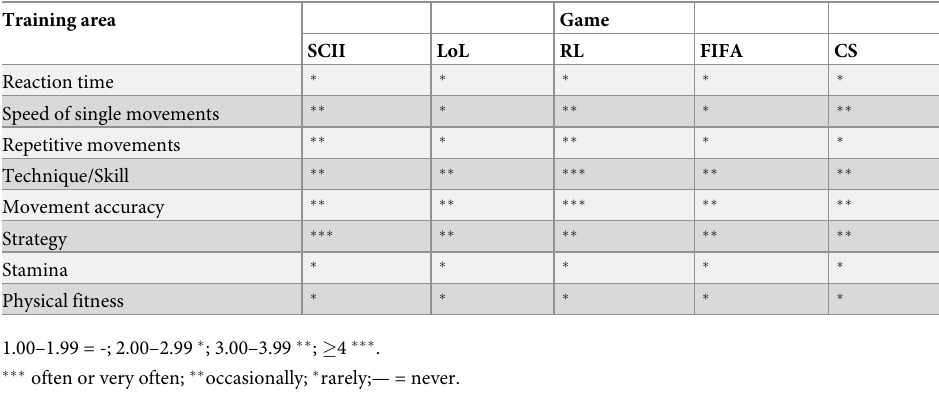
Table 29. Results regarding the differences between the esports in training area